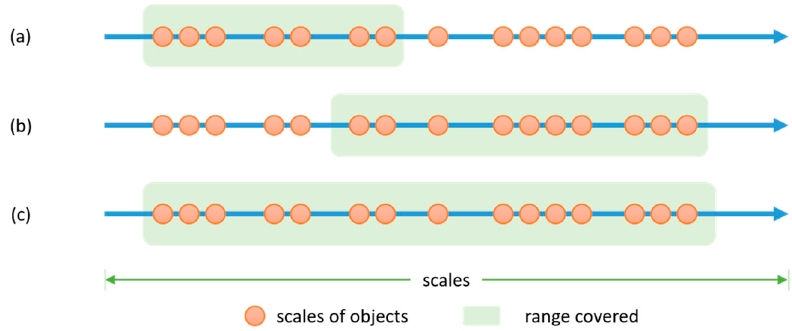
Figure 5. An example to illustrate the relation of the single-feature between the object scales and the scale range covered. Circle number represents the scale of object across the scale, the more the circle, the larger the scale. ( a ) the original receptive field, ( b ) dilated receptive field shifts to larger scale, ( c ) all the scales covered by stacked residual